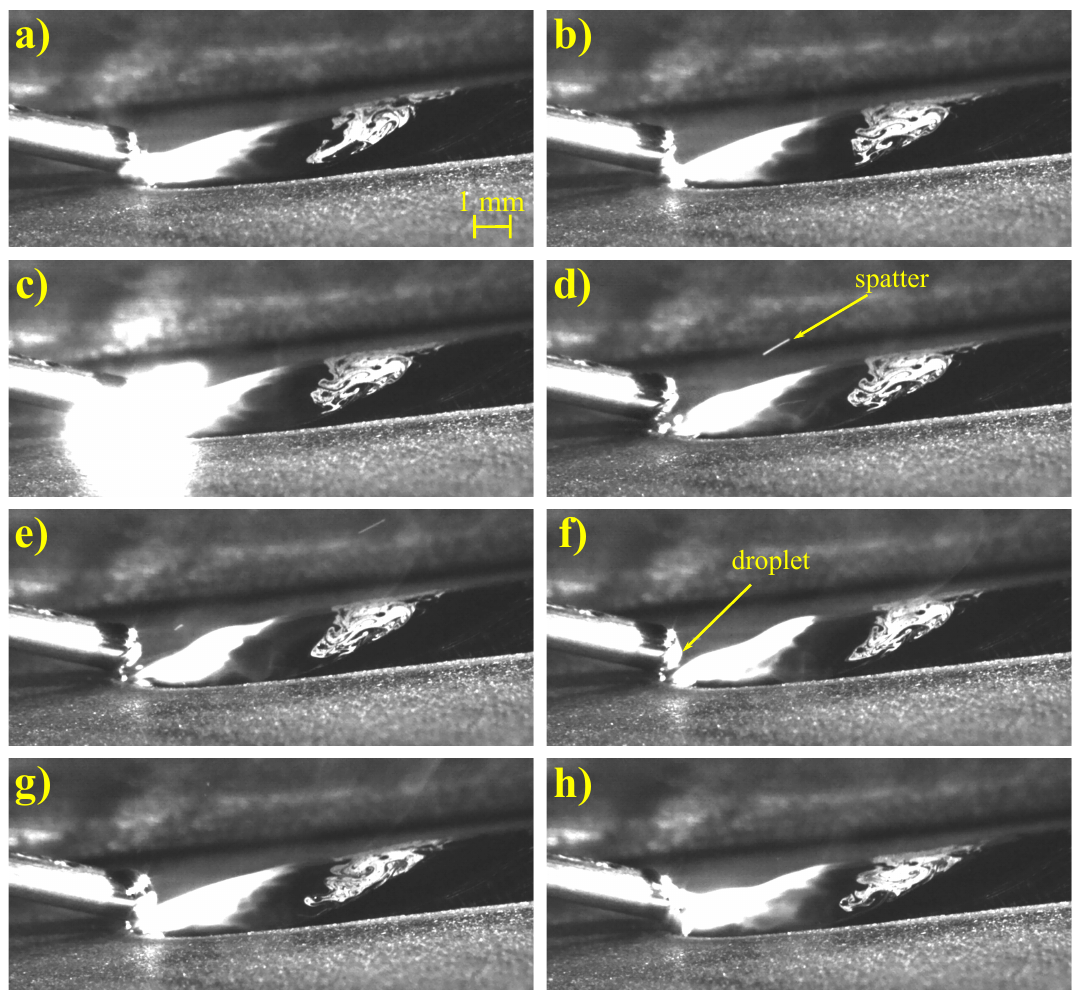
Figure 7. The sequence of images acquired by the off-axis high-speed camera showing the process instability when the medium laser power and high hot-wire level (L6) were applied: ( a ) the transition link between the molten wire and the melt pool ( t = 1.659232 s), ( b ) the narrowing transition link between the molten wire and the melt pool ( t = 1.682776 s), ( c ) the arcing occurring with the break of the transition link ( t = 1.684015 s), ( d ) the spatter ( t = 1.685254 s), ( e ) the disturbed melt pool surface ( t = 1.686493 s), ( f ) the start of droplet formation ( t = 1.686493 s), ( g ) the development of the droplet ( t = 1.697646 s), ( h ) the temporarily reconnection of the molten wire and the melt pool ( t = 1.702602